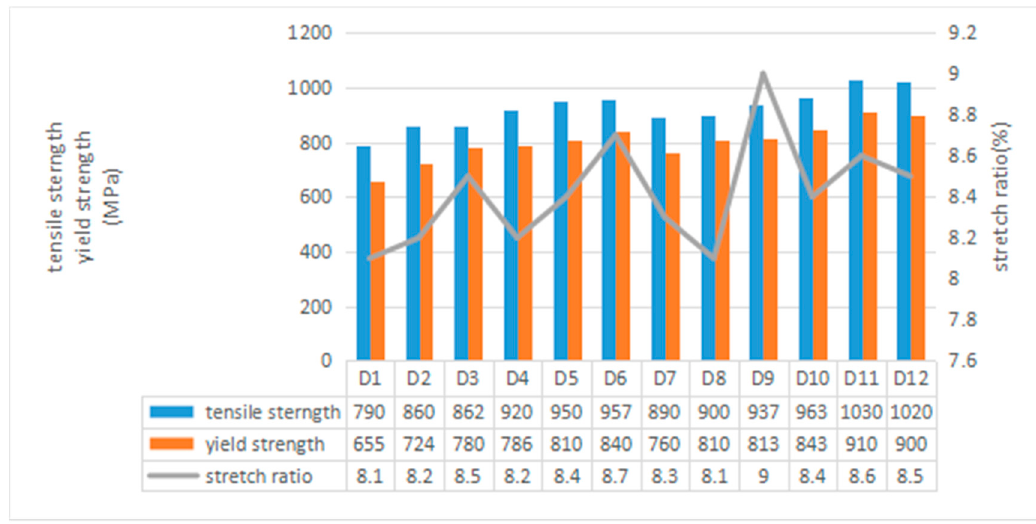
Figure 11. Mechanical properties of the specimens.